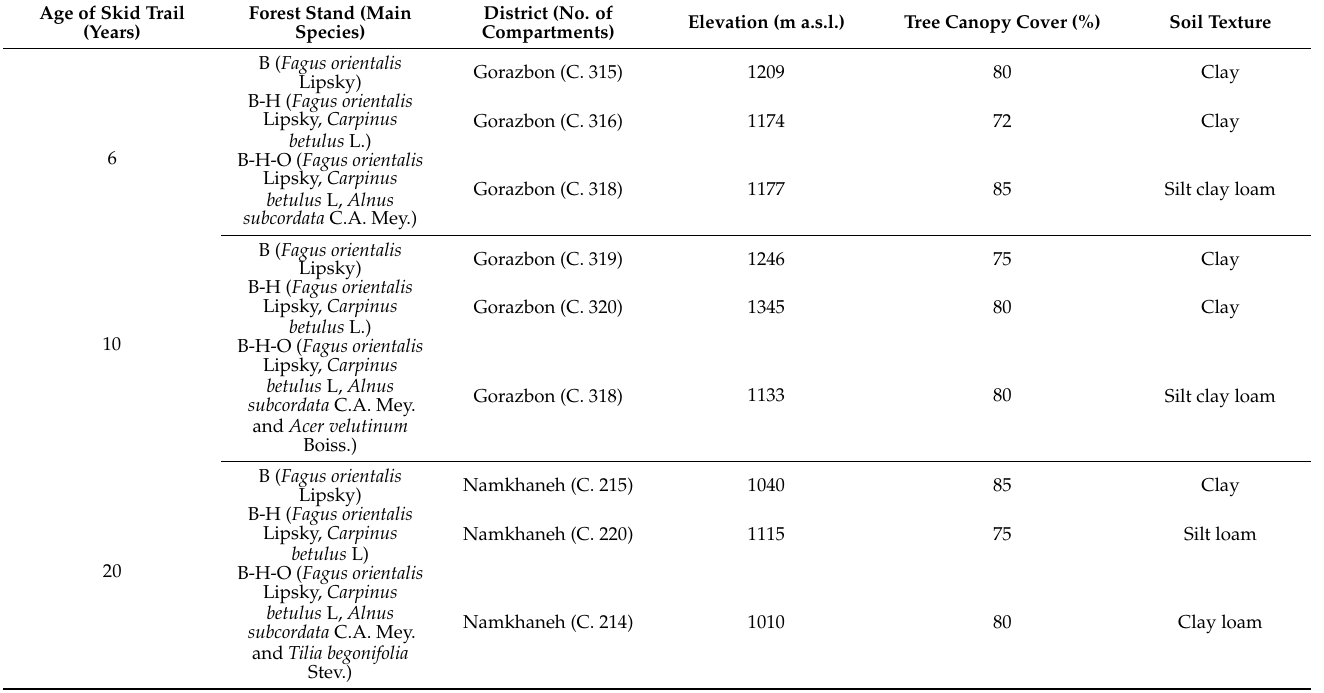
Table 1. Description of the skid trail/forest stand in the study area, northern Iran. B: beech, B-H: beech–hornbeam, B-H-O: mixed beech, and UND: undisturbed